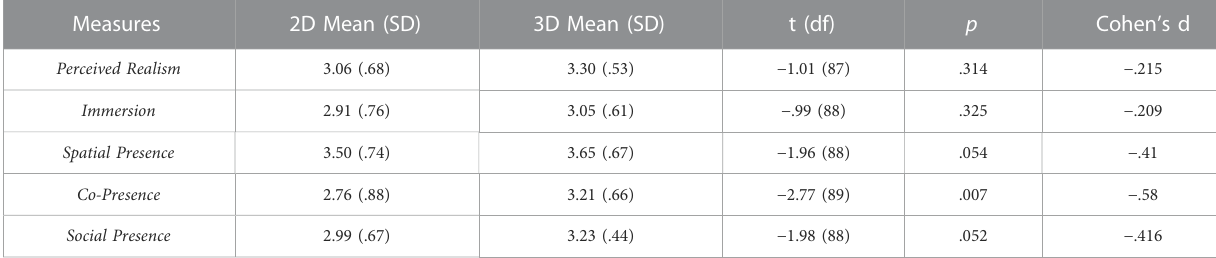
TABLE 2 t -test comparisons for perceived realism, immersion, spatial presence, co-presence, and social presence.